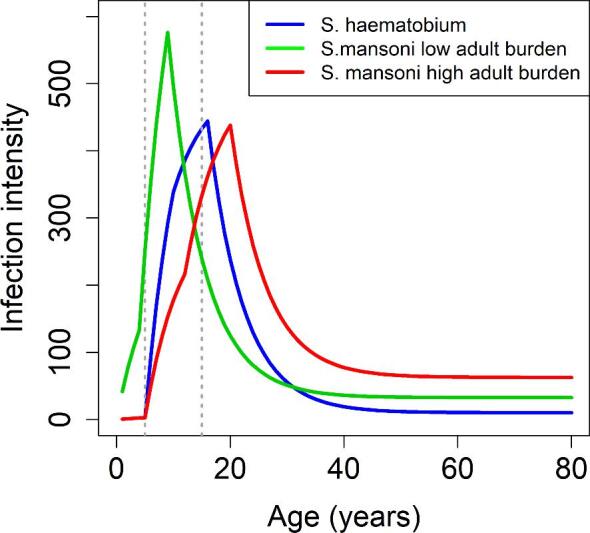

S. mansoni and S. haematobium age-intensity profiles of infection (eggs/10 mL for S. haematobium and eggs/gram for S. mansoni, showing low and high burden of adult infection settings).17,33